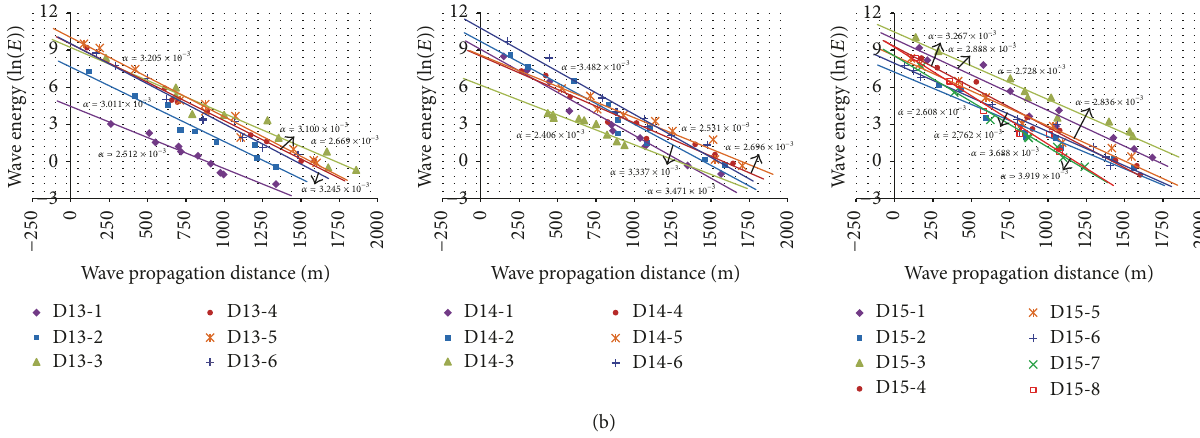
Figure 6: Linear relations of logarithmic residual wave energy and wave propagation distance for the great sample